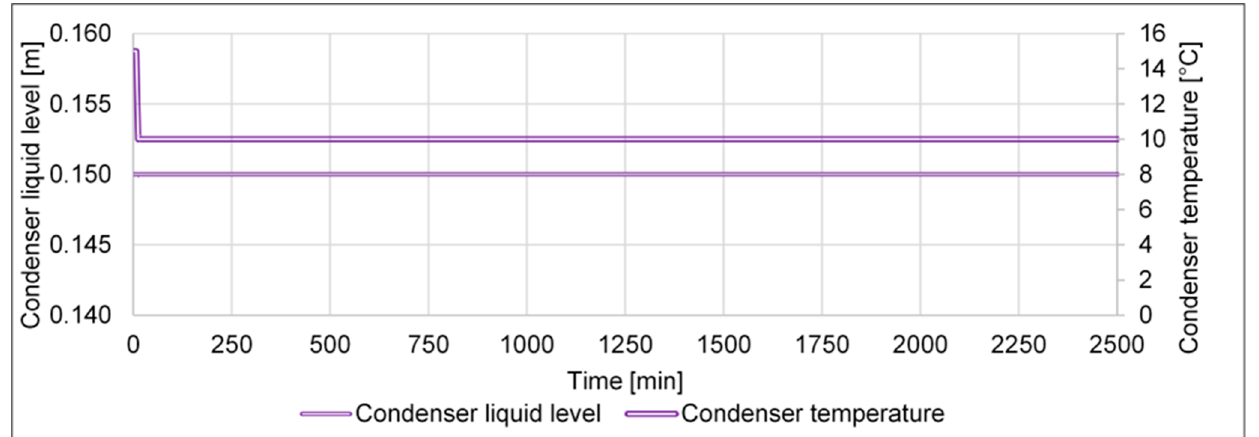
Figure 20 . Condenser liquid level and position of the recycle valve (left and right vertical axis) of scenario (h).